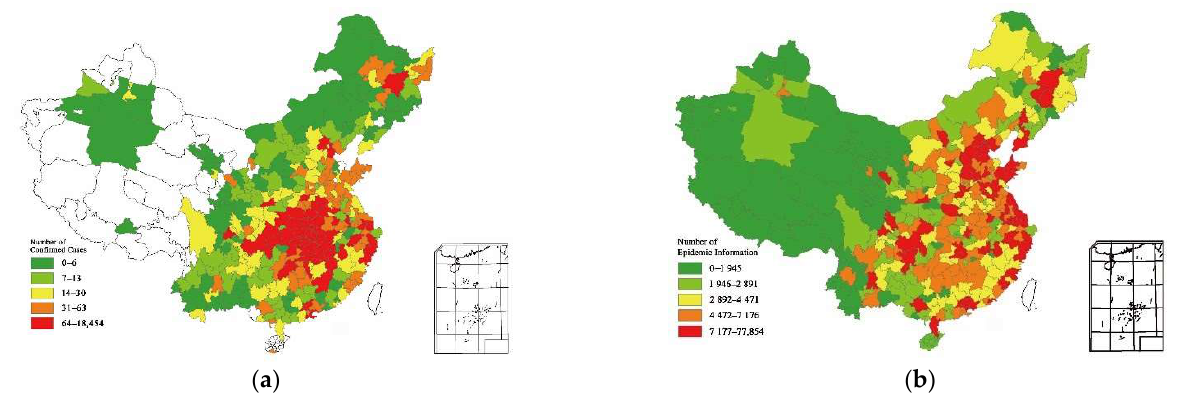
Figure 2. The geographical distribution of COVID-19 and epidemic information in China as of 10 February 2020. ( a ) The confirmed cases are distributed radially from Wuhan. ( b ) Geographical Distribution of Epidemic Information in China as of 10 February 2020.